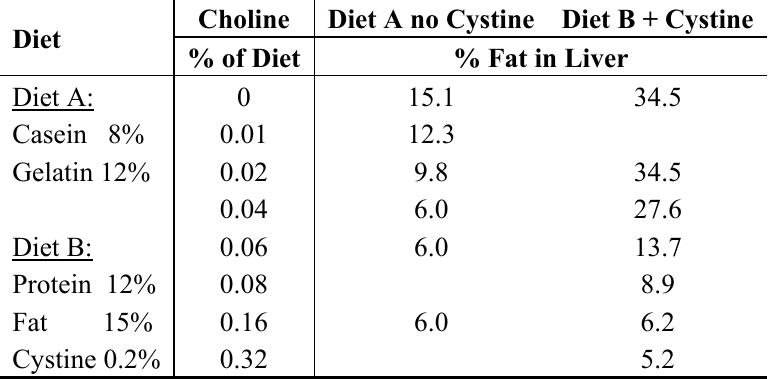
Table 3. Effect of Choline (from [9] and